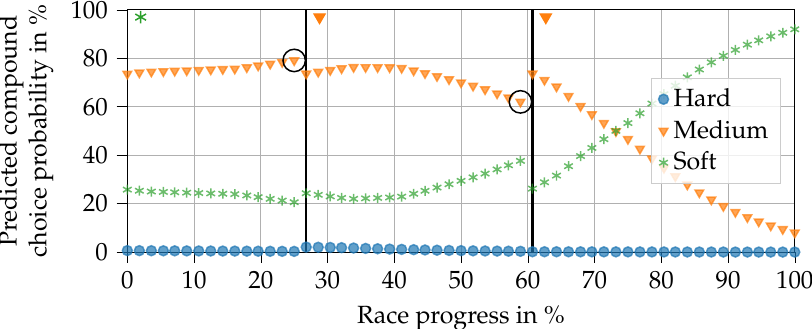
Figure 12. Progressions of the predicted compound choice probabilities for Gasly using real input data from the 2019 Brazilian Grand Prix. The vertical lines indicate a real pit stop. The symbols to the right of the lines at the top of the figure represent the actual compound fitted in the corresponding stint. The race was excluded from the training data.